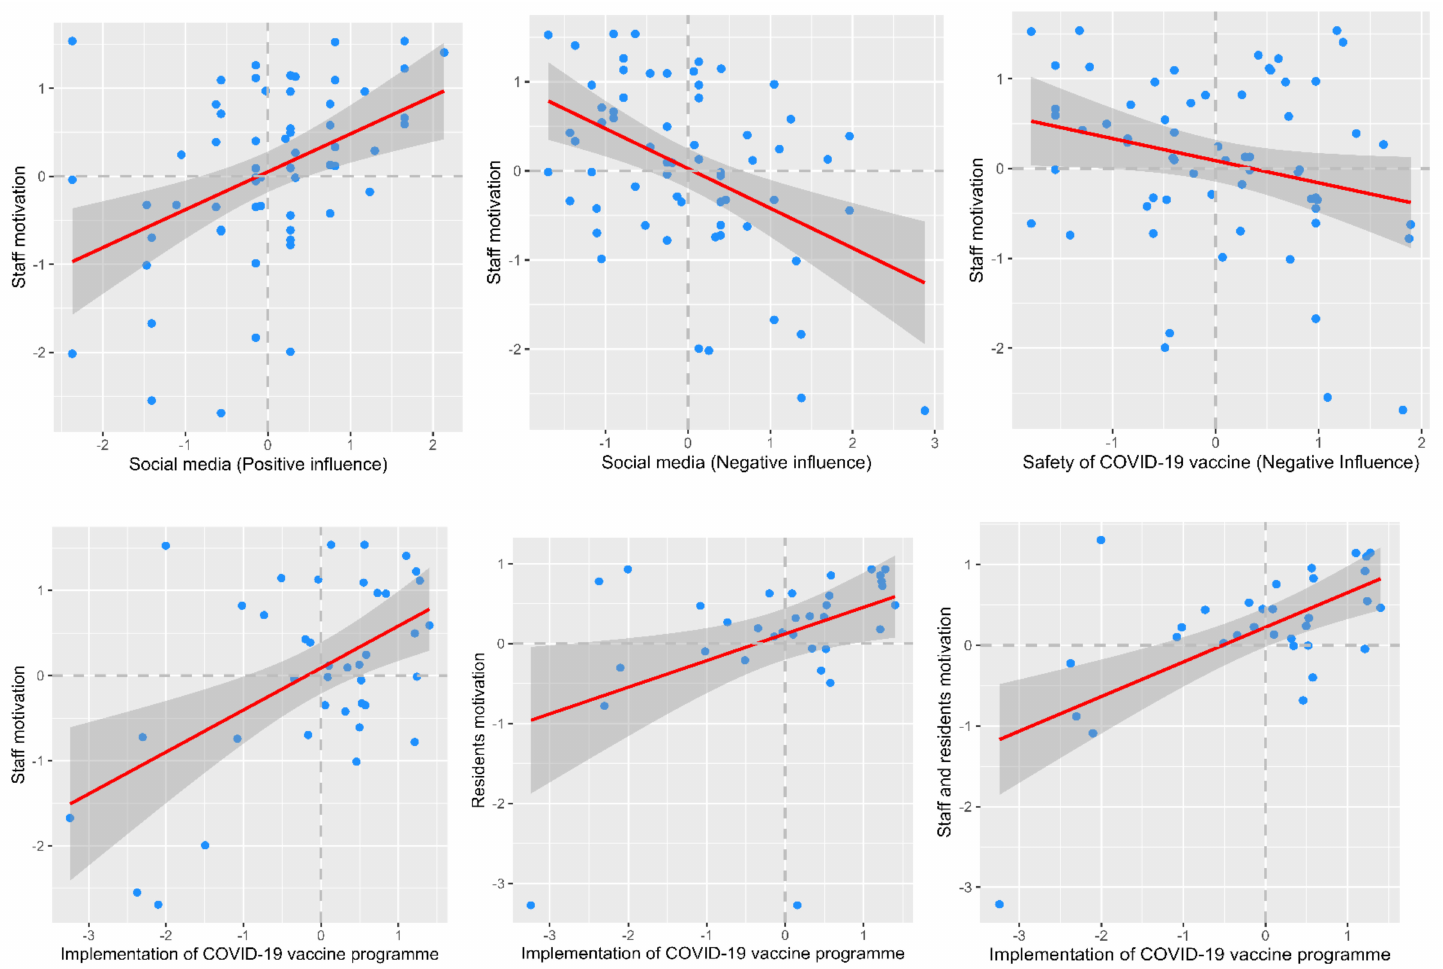
Figure 1. Plots for the relationship between staff and residents’ motivation, social media, safety, and programme and